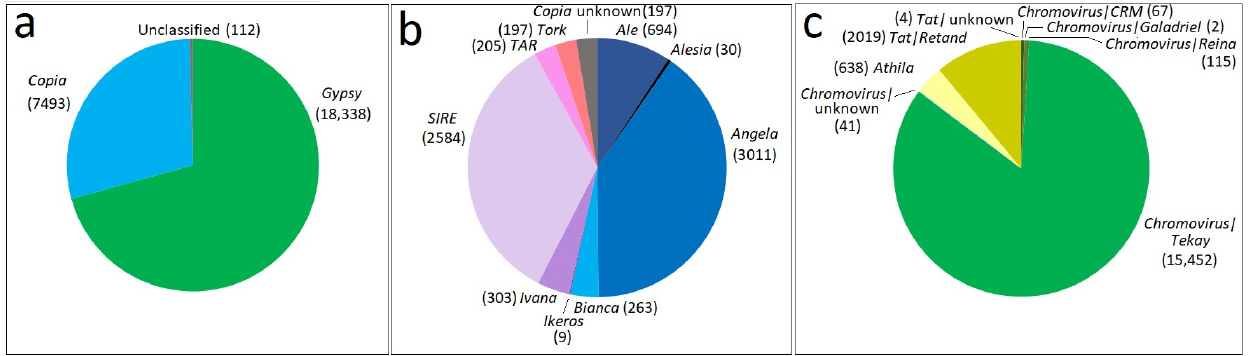
Figure 1. Pie charts of the distribution of full-length LTR-REs in the S. rebaudiana genome considering both superfamilies ( a ) and Copia ( b ) and Gypsy ( c ) lineages. The number of elements for each LTR-RE superfamily or lineage is shown in the brackets.